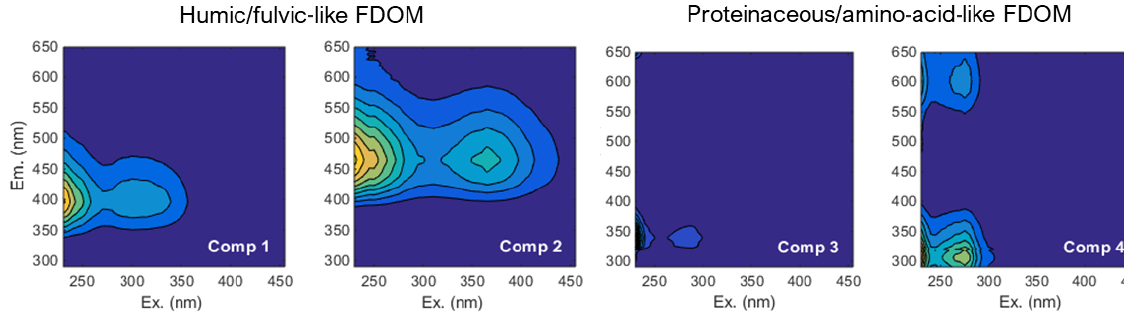
Figure 5. Four components, which were found and validated by PARAFAC analyses after Murphy et al. (2013)